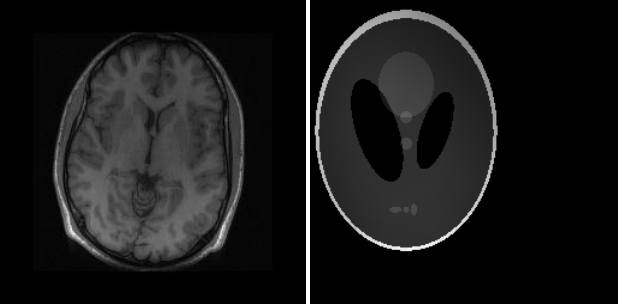
Figure 7. Groundtruth images: Brain and Shepp-Logan Phantom.